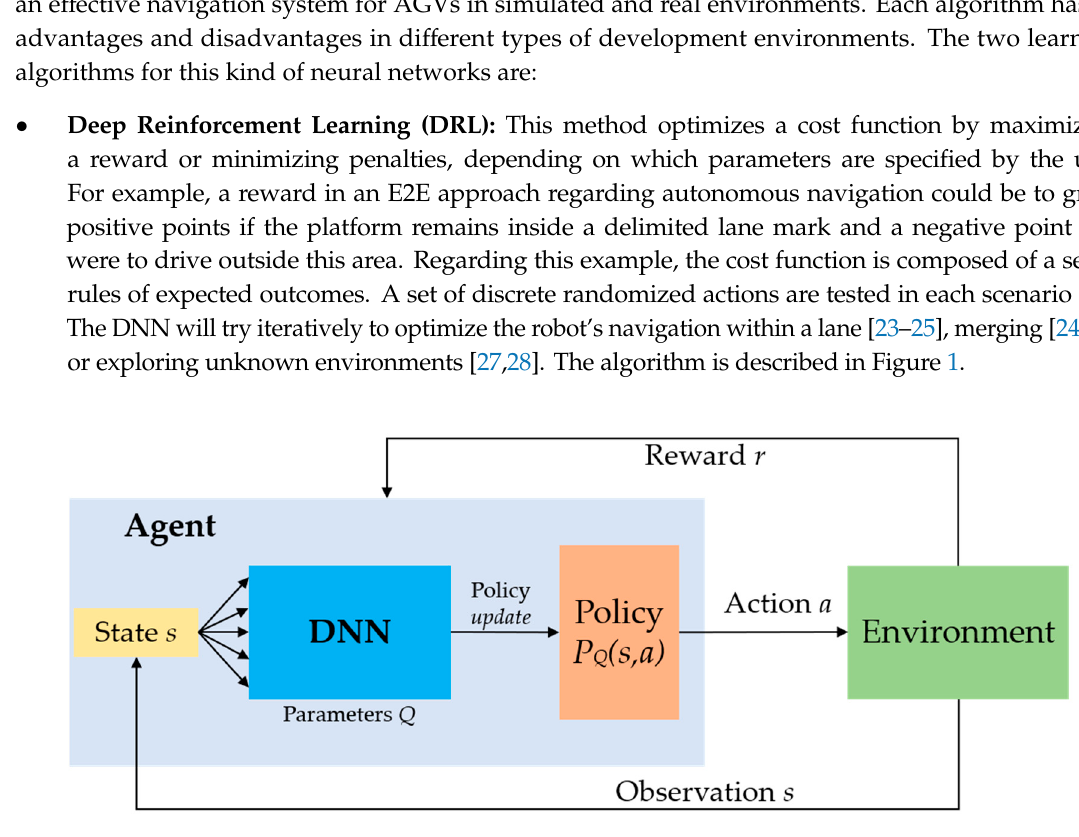
Figure 1. Deep Reinforcement Learning (DRL) diagram.